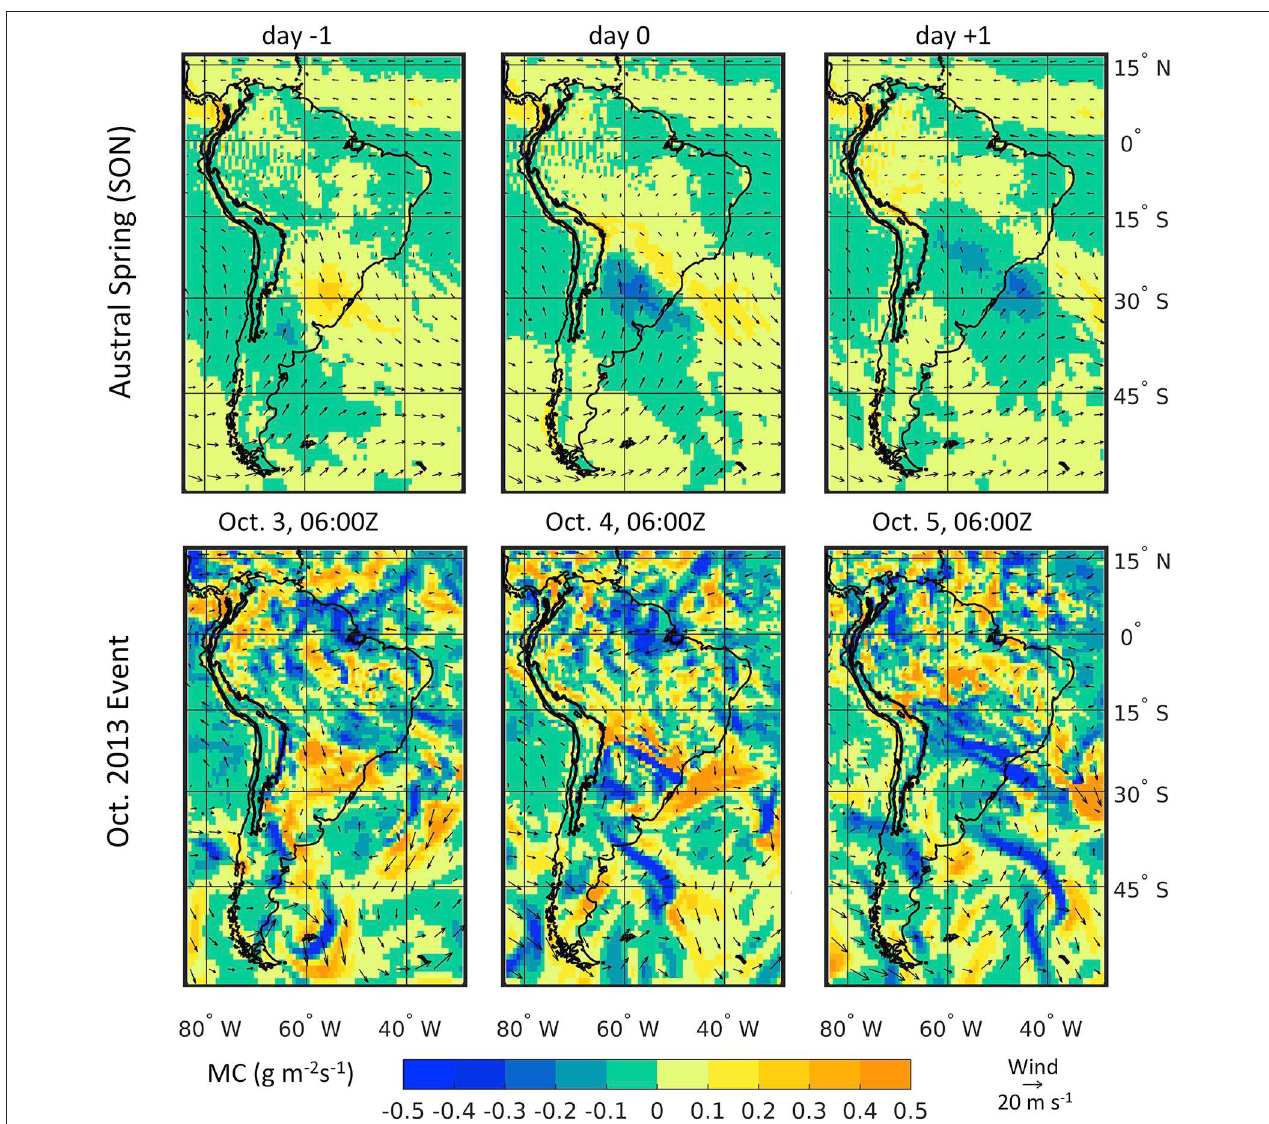
FIGURE 9 | Top row: Composite vertically integrated Moisture Convergence ( MC ) patterns overlain on 850 hPa horizontal winds in the austral spring (SON) between 1979 and 2017 from ERA-Interim. The black contour line marks the 2000 m elevation. Bottom row: similar plots for the case-study CAI.